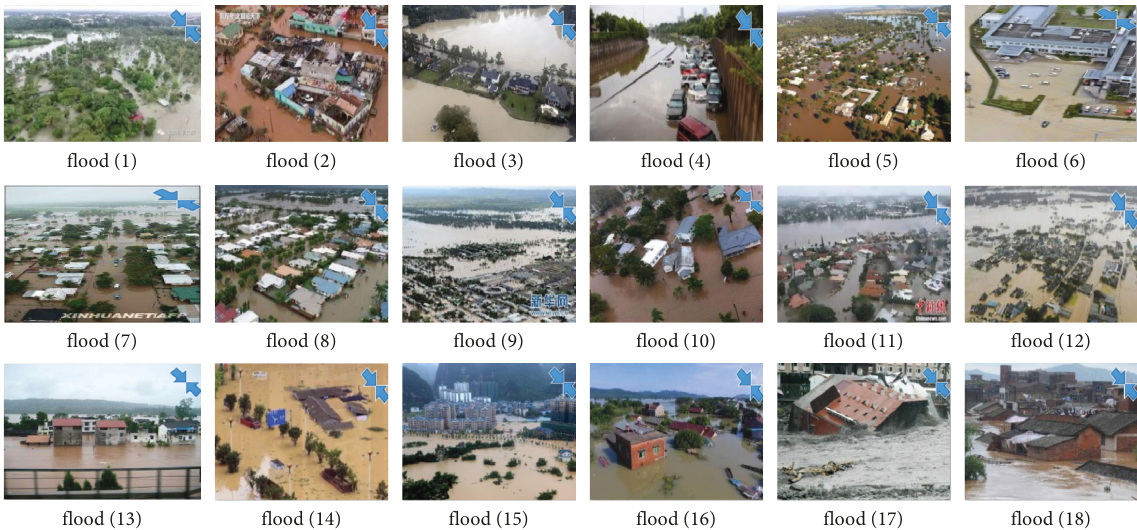
Figure 7: The YOLOv3 object detection method.